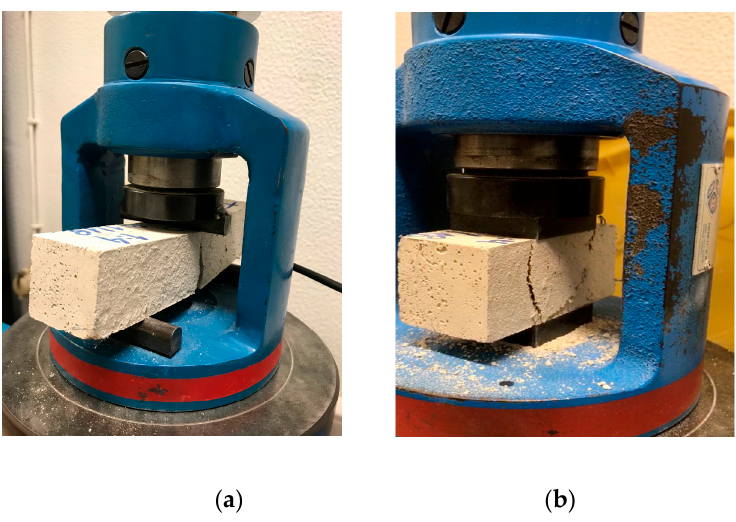
Figure 11. Flexural strength test ( a ); compressive strength test ( b ).